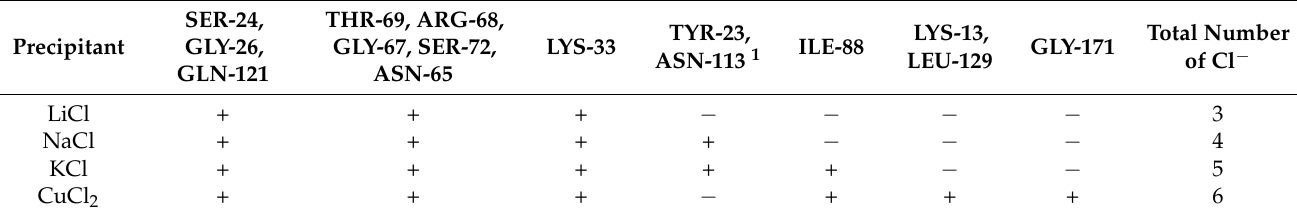
Table 3. The presence of chlorine ions in different sites of lysozyme monomer depending on precipitant nature. Every site is designated by the residues to which chloride ion is associated.